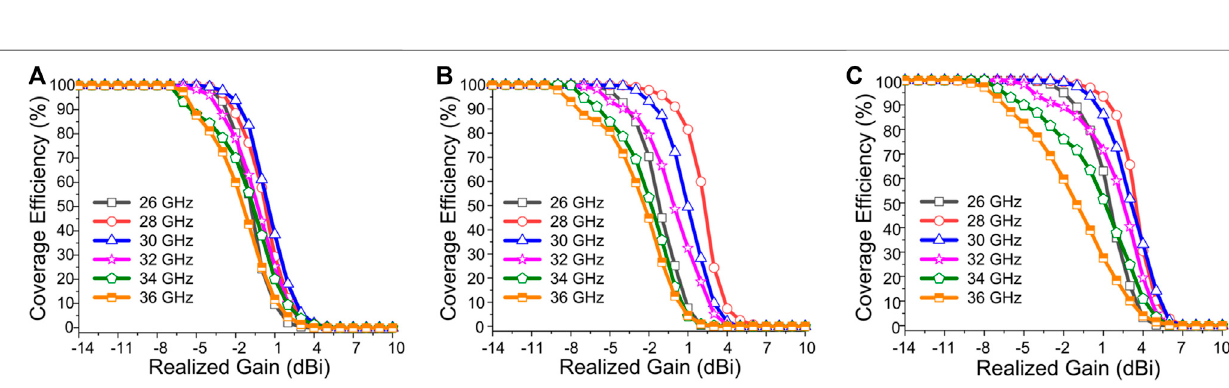
FIGURE 12 | Simulated total scan patterns (36 GHz) of the designed array antennas in the handset mockup. (A) CPW TL. (B) GCPW TL without via fences. (C) GCPW TL with via fences.